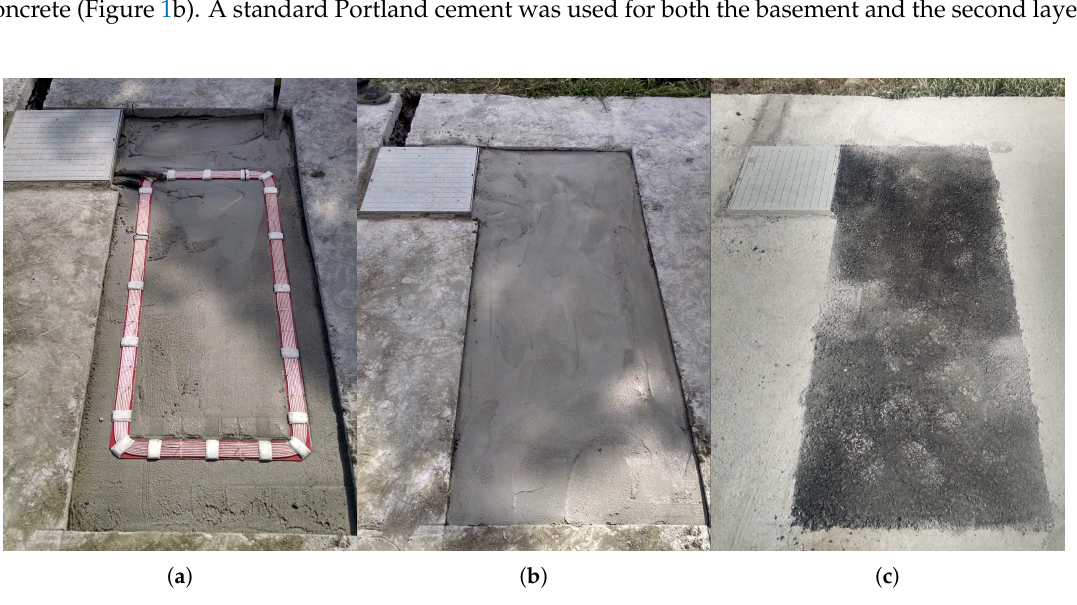
Figure 1. Phases of the coil embedment. Coil placed on the concrete basement ( a ); coil covered with a second concrete layer ( b ); coil covered with a final cold asphalt layer ( c